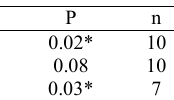
) between Table 3. Coefficients of the linear correlation (r obs carnivores’ density and species richness (Car-S), omnivores density and species richness (Oni-S) and invertivores density and equitability (Inv-J’). X = average of r after 1000 rsim resamples, s 2 = variance of r after 1000 resamples, p = exact Fsim probability, * = statistically significant values and n = sample